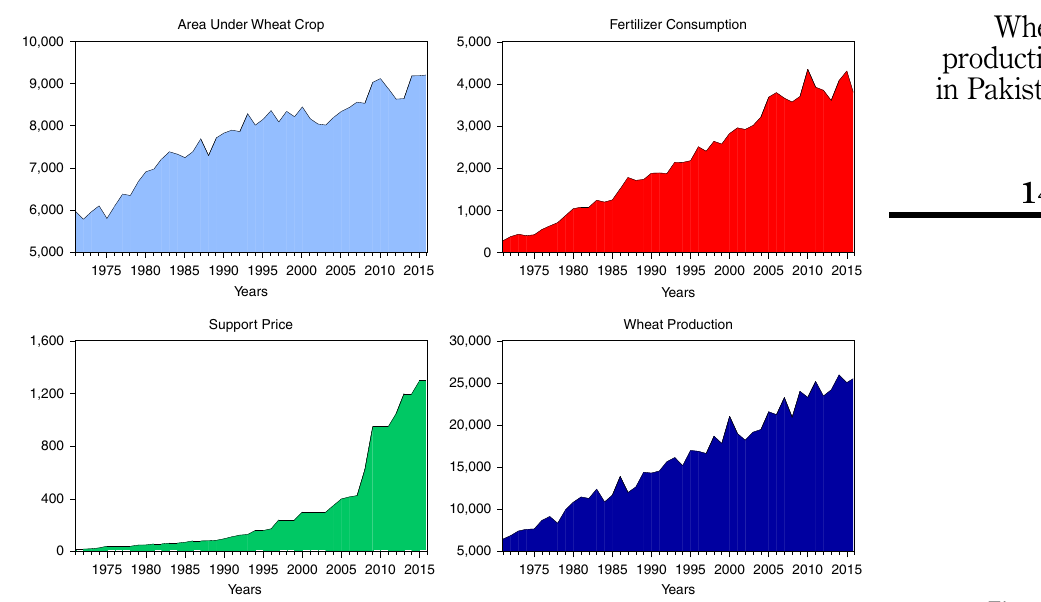
Figure 1. Trends of the